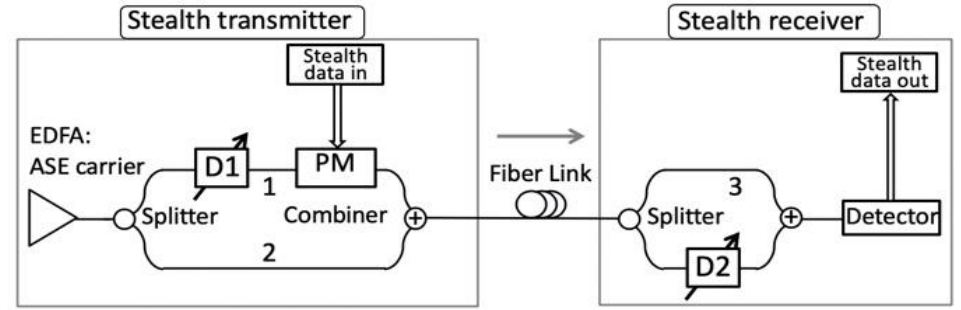
Figure 5. Schematic diagram of optical stealth communication [73].